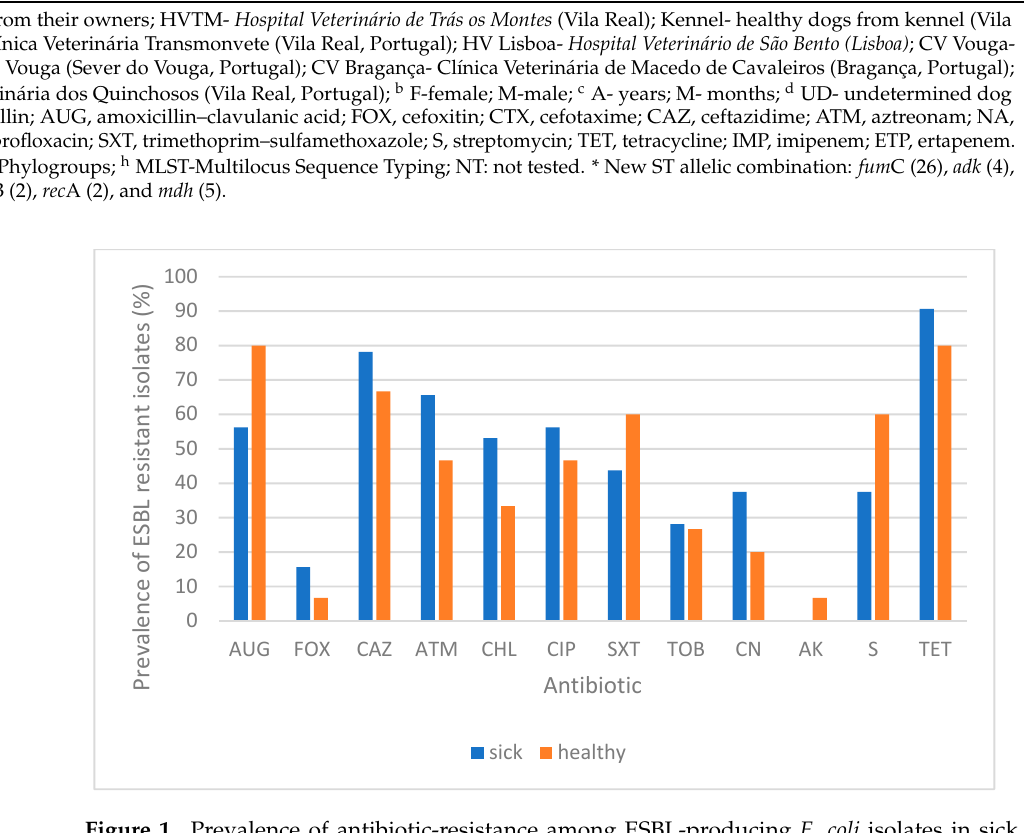
no statistical difference could be established between the origin of the strain (healthy or sick dog) and the ESBL type ( p > 0.05) (Figure 2), except for CTX-M-32, in which this relation was present (it was detected just in healthy